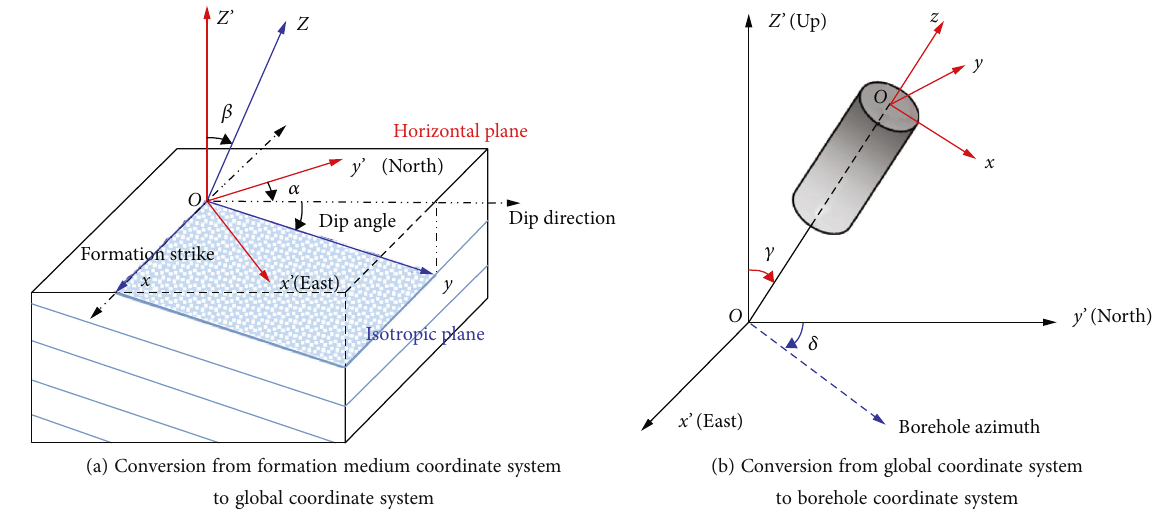
Figure 5: Coordinate transformation of the elastic